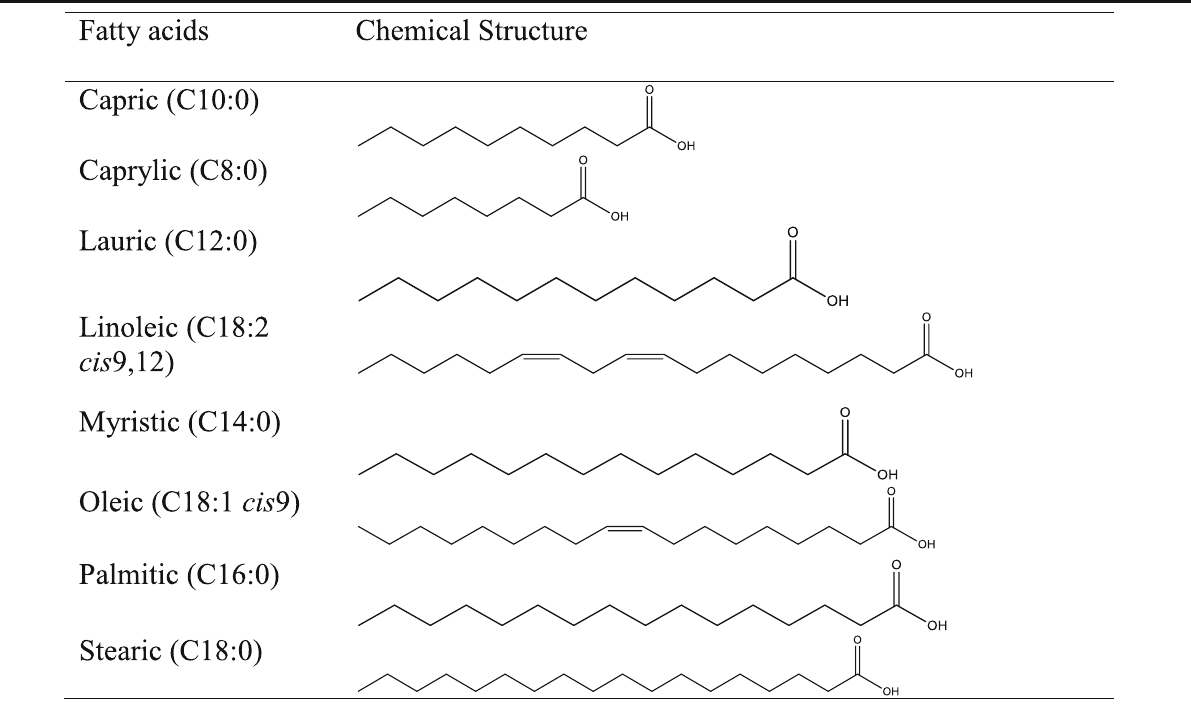
Table 1 The fatty acids selected for the studies